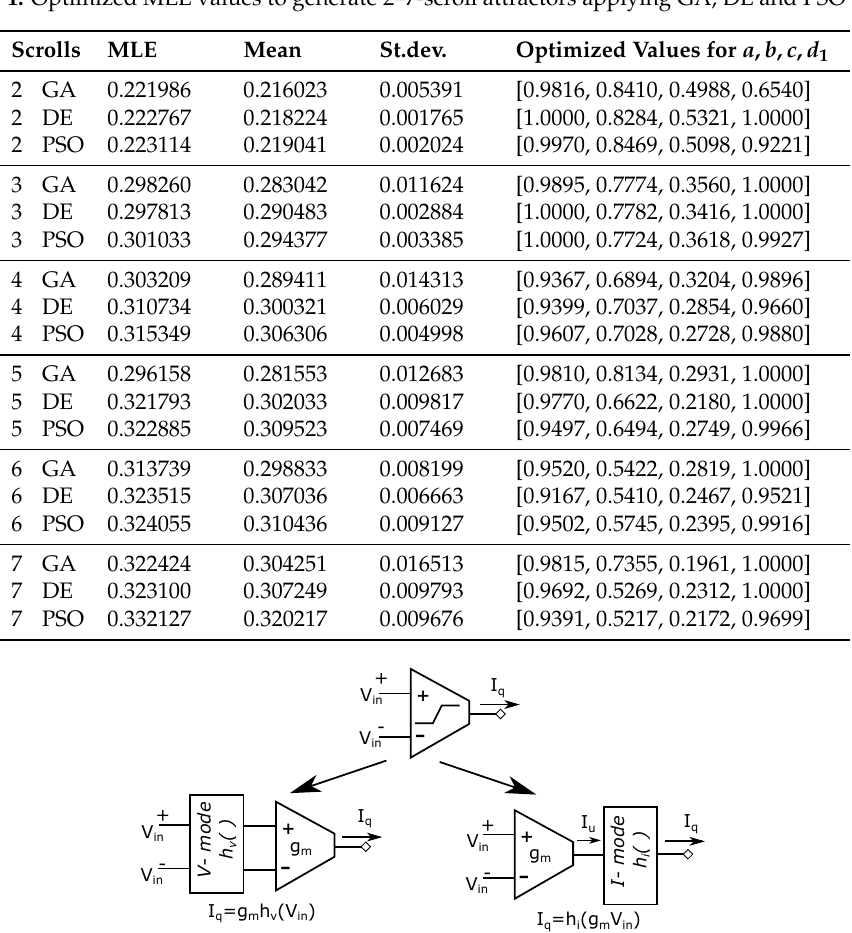
Table 1. Optimized MLE values to generate 2–7-scroll attractors applying GA, DE and PSO [51].